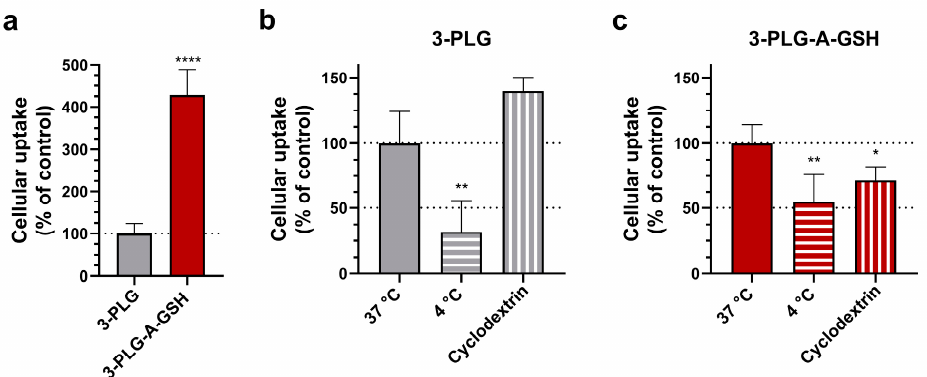
Figure 7. Cellular uptake and mechanism of polypeptide nanocarrier cell entry. ( a ) Uptake of 3-PLG and 3-PLG-A-GSH nanocarriers in human brain endothelial cells (4 h; 50 μ g/mL). Values are means ± SD and given as a percentage of the non-targeted 3-PLG data. Statistical analysis: unpaired t -test, **** p < 0.0001, compared to the 3 PLG group. The effect of low temperature (4 °C) and endocytosis inhibitor randomly methylated β -cyclodextrin (5 mM) on the uptake of ( b ) 3-PLG and ( c ) 3-PLG-A-GSH. Values are means ± SD and given as a percentage of the control group (37 °C data, no inhibition). Statistical analysis: one-way ANOVA, Dunnett test, * p < 0.05, ** p < 0.01 compared to the respective control groups of 3-PLG and 3-PLG-A-GSH treatments; n = 6.